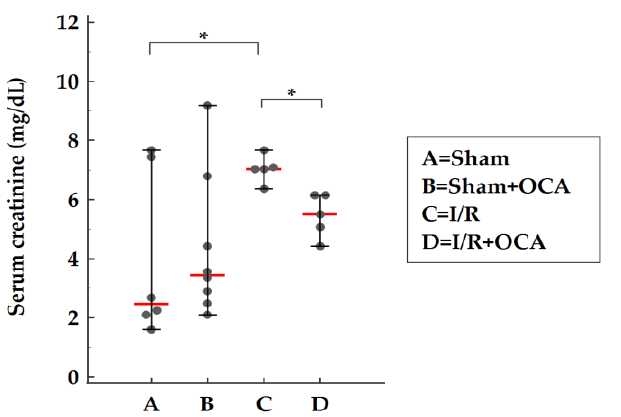
Figure 3. OCA treatment decreases serum creatinine in rats submitted to partial liver ischemia (60 min) followed by reperfusion (120 min). Animals were orally administered 10 mg/kg/day of OCA in methylcellulose 1% vehicle for 5 days ( n = 12) or vehicle alone ( n = 12). Sham-operated animals were subjected to the same procedure without clamping the vessels. n = 6 rats/group. Results are expressed as median value (red line) ± error bar (1–99 percentiles) (black dot). one-way ANOVA with Tukey–Kramer test. * p < 0.05 versus I/R rats.